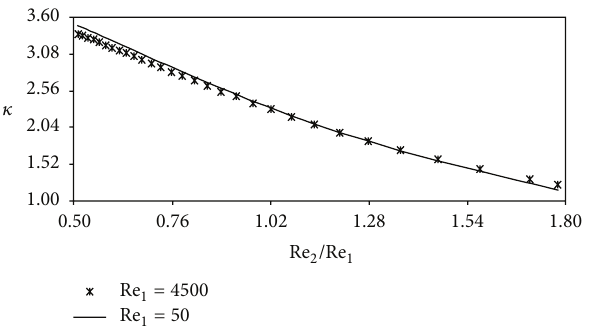
Figure 4: Variations of compression rate with respect to Re 2 / Re 1 .